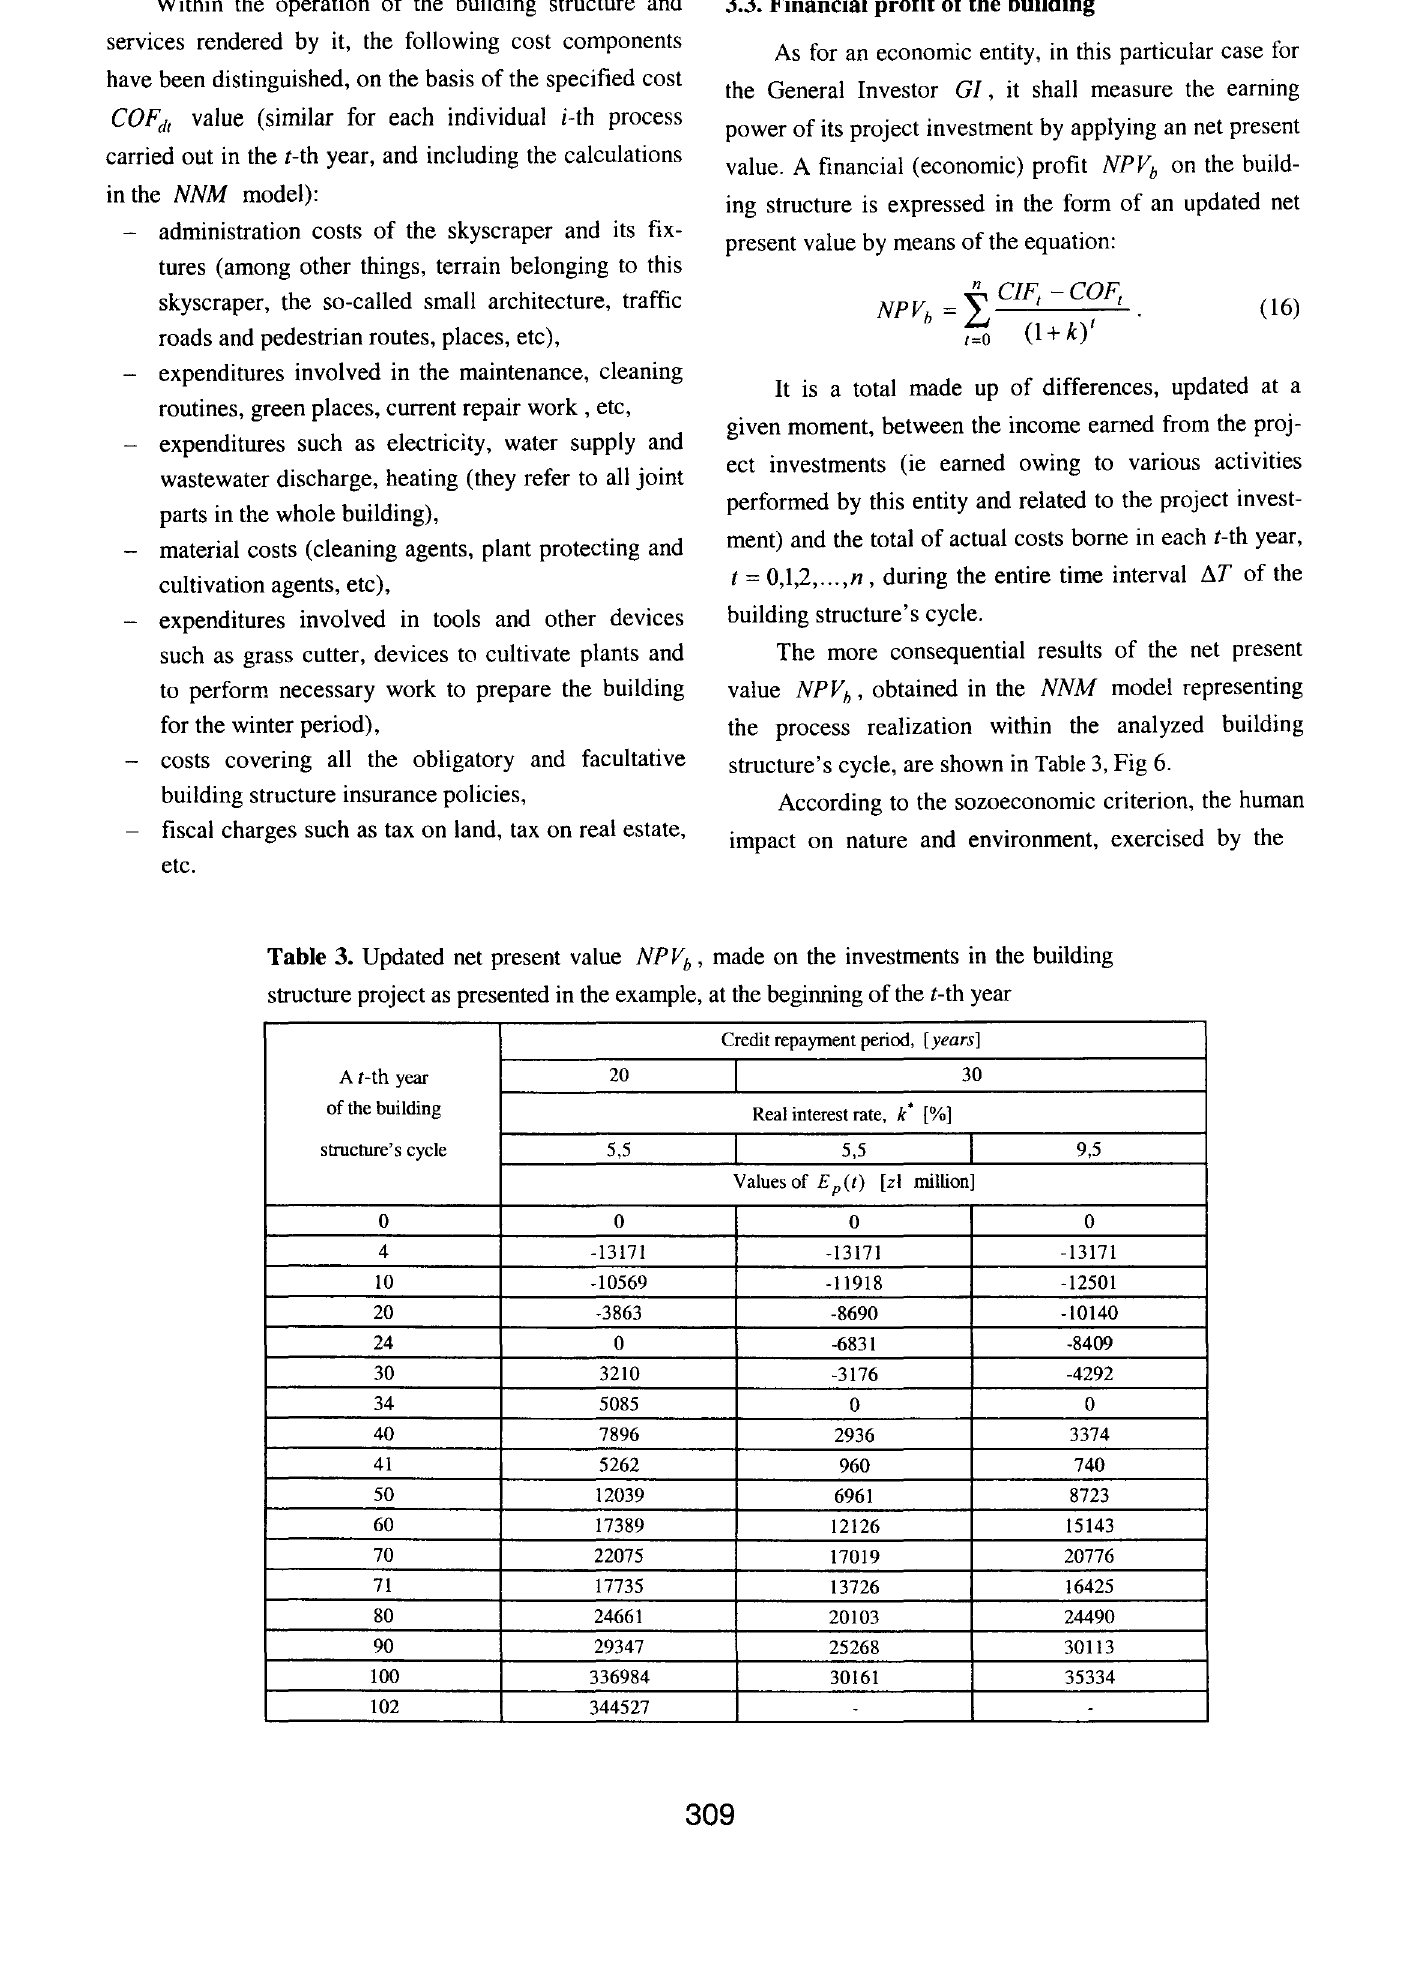
Table 3. Updated net present value NPVb, made on the investments in the building structure project as presented in the example, at the beginning of the t-th